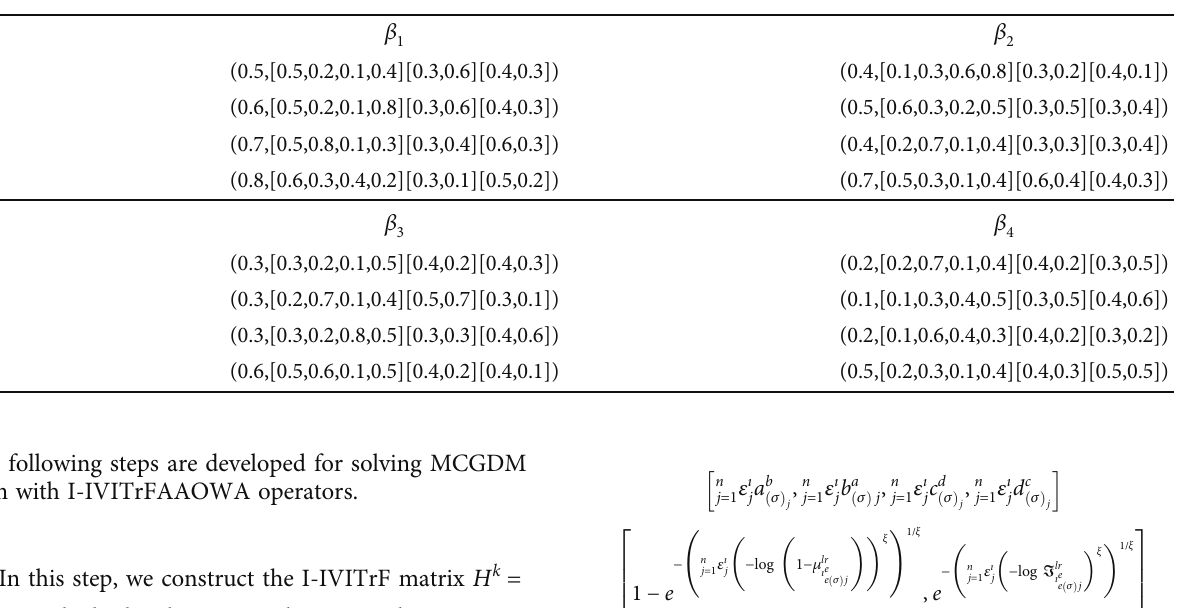
Table 5: Decision matrix of expert -5 (H 5 ).